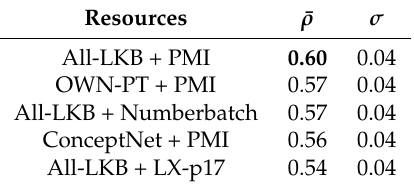
Table 18. Top Spearman correlations ( ρ ) for WordSim-353, based on the average of two different